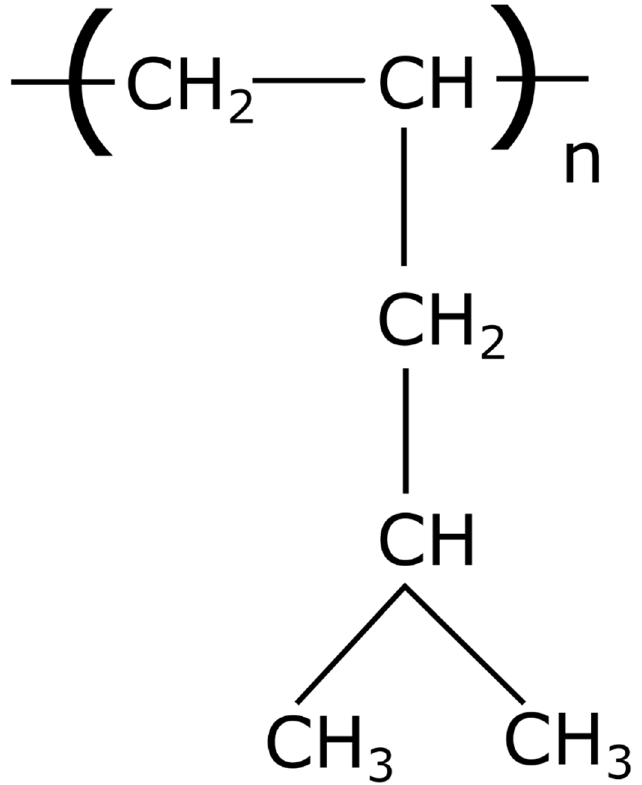
Figure 1. Structural formula of poly(4-methyl-1-pentene).